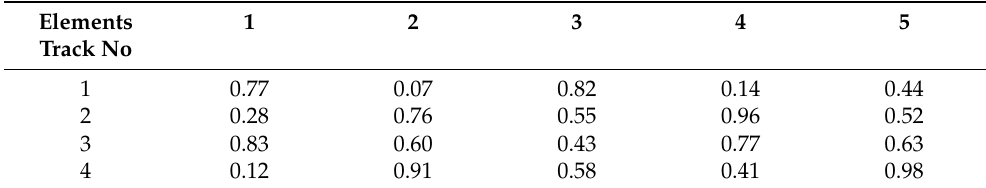
Table 1. NP of initial